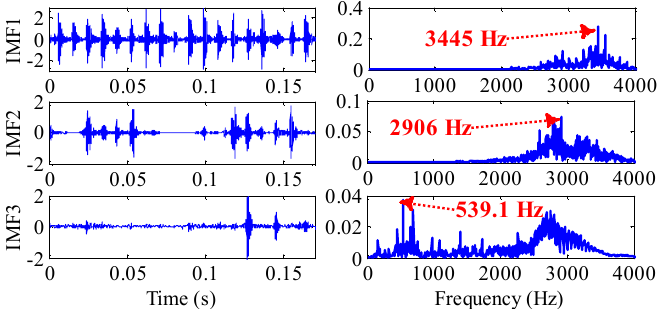
successfully decomposed. In addition, the frequencies of IMFs obtained by decomposition